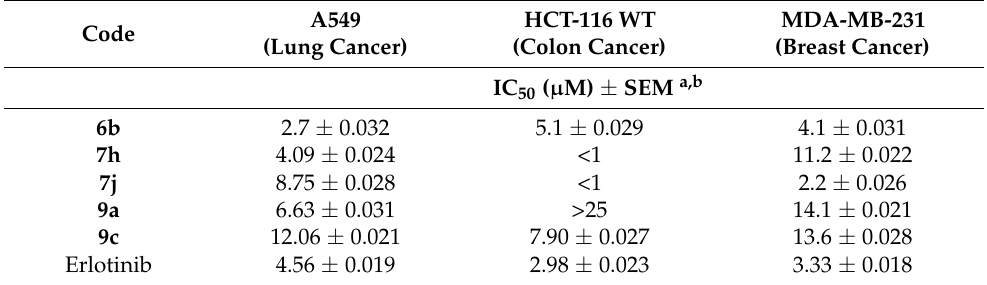
Table 2. Antiproliferative potential of 6b , 7h , 7j , 9a and 9c against human cancer cells.